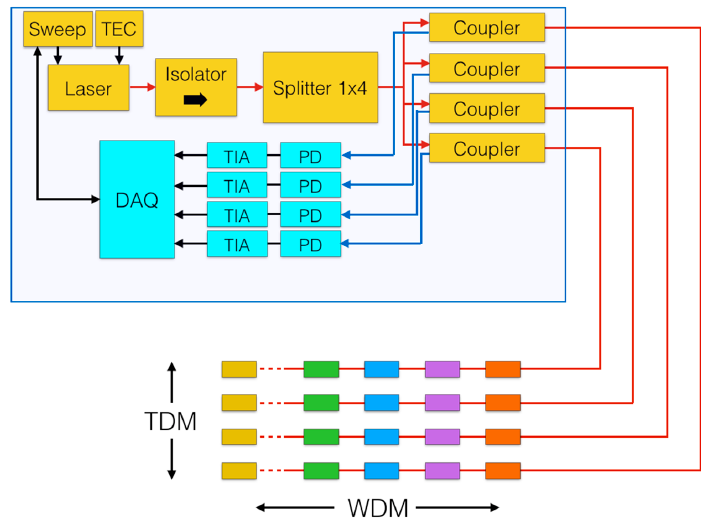
Figure 3. Schematic of scanning-laser interrogation system for FBG sensor networks. Red/blue lines show optical connections, black lines show electrical connections; the blue box includes all the building blocks of the interrogator. Colored sensors refer to FBG arrays (one wavelength per color).